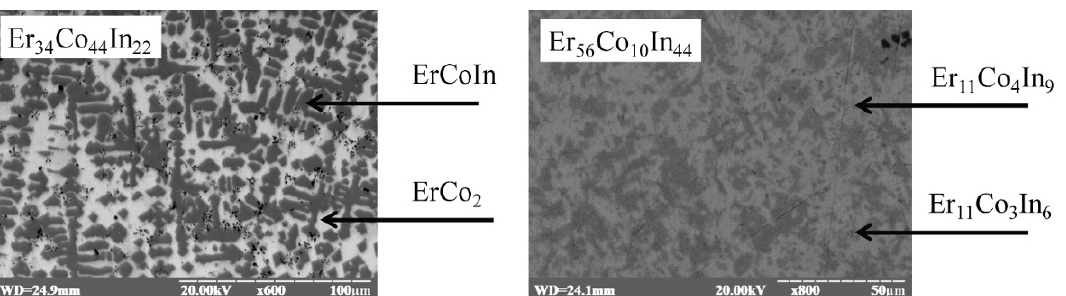
Figure 3. Microphotographs of Er